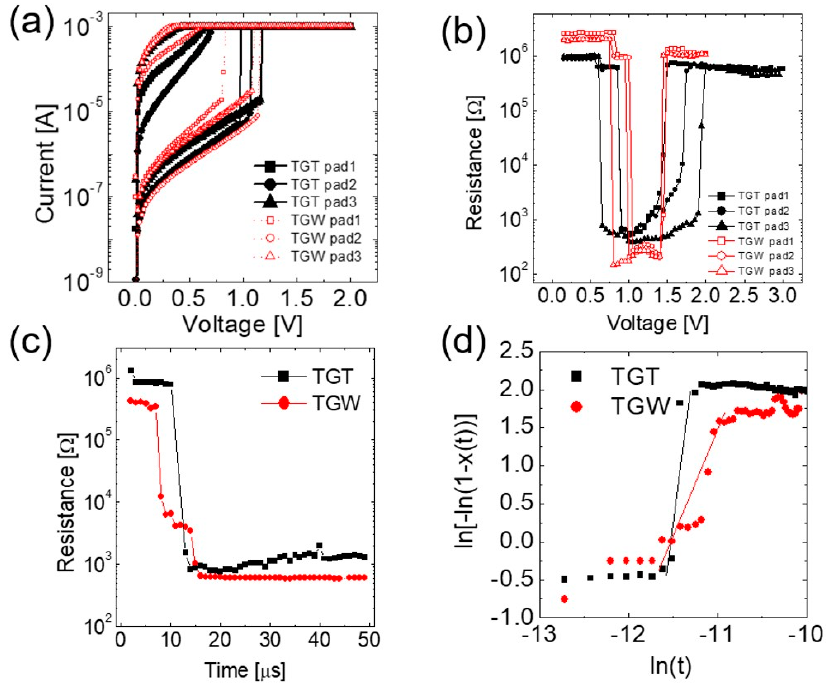
Figure 2. ( a ) Set switching of TGT and TGW devices induced by DC I–V (pad number means the di ff erent memory cells in the device). ( b ) Set and reset switching of TGT and TGW devices representing R–V curves induced by AC pulse with 1 µ s width. ( c ) Voltage pulse-induced set transition of TGT and TGW devices, where consecutive voltage pulse train with 1 µ s width (0.45 V for TGW and 0.6 V for TGT) was used. ( d ) Set transitions of both devices were expressed as a JMA plot.